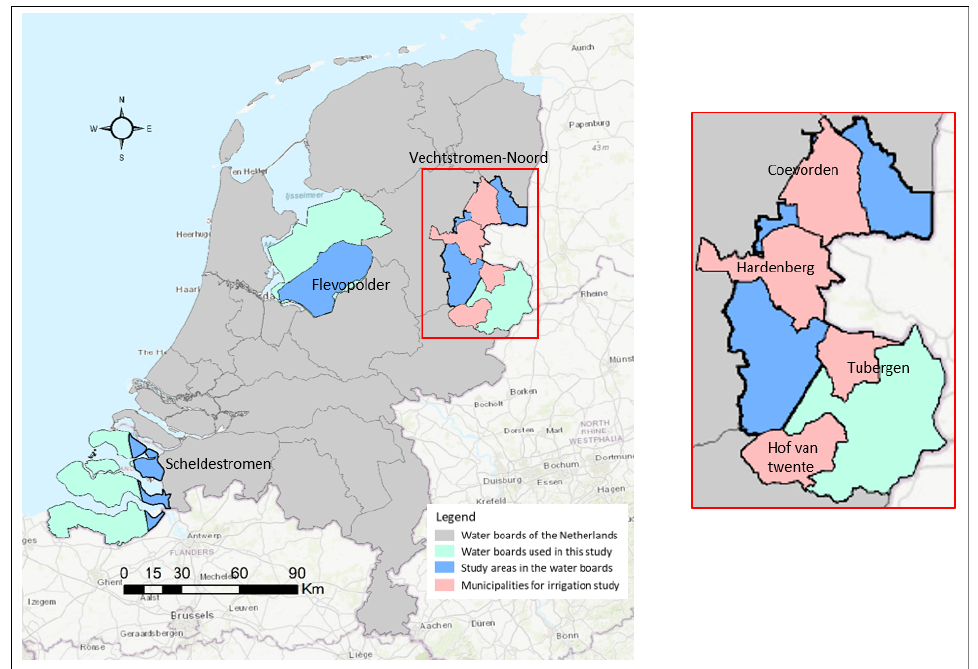
Figure 1. The location of three areas of interest (blue) in province map of the Netherlands. Vechtstromen-Noord, Flevopolder and Scheldestromen areas are part of the Vechtstromen, Zuiderzee- land and Scheldestromen water boards. The inset shows the municipalities within the Vechtstromen water board used to study the effect of irrigation